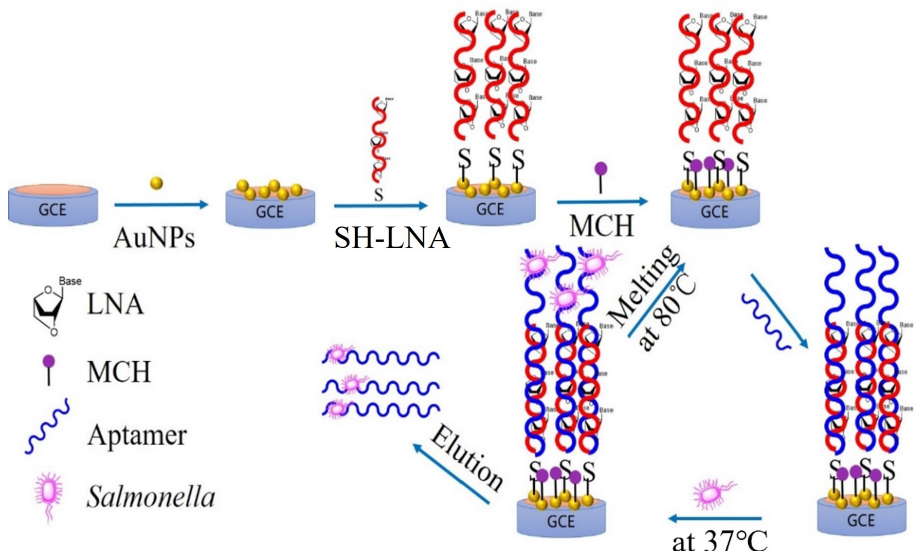
Figure 7. Schematic representation of the preparation of the renewable electrochemical biosensor step by step. step by